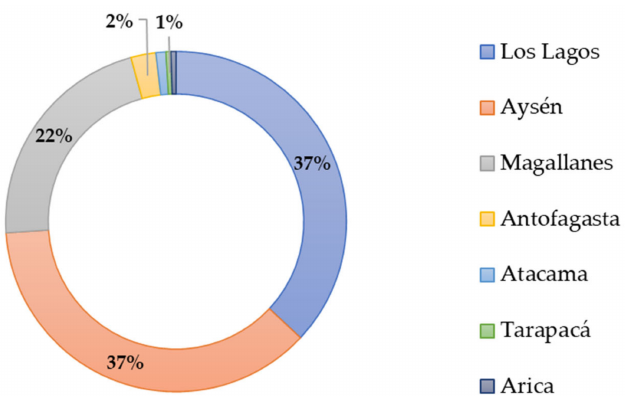
Figure 15. Regional distribution of HABs associated with harmful effects in farmed fish and mortality of other marine organisms in